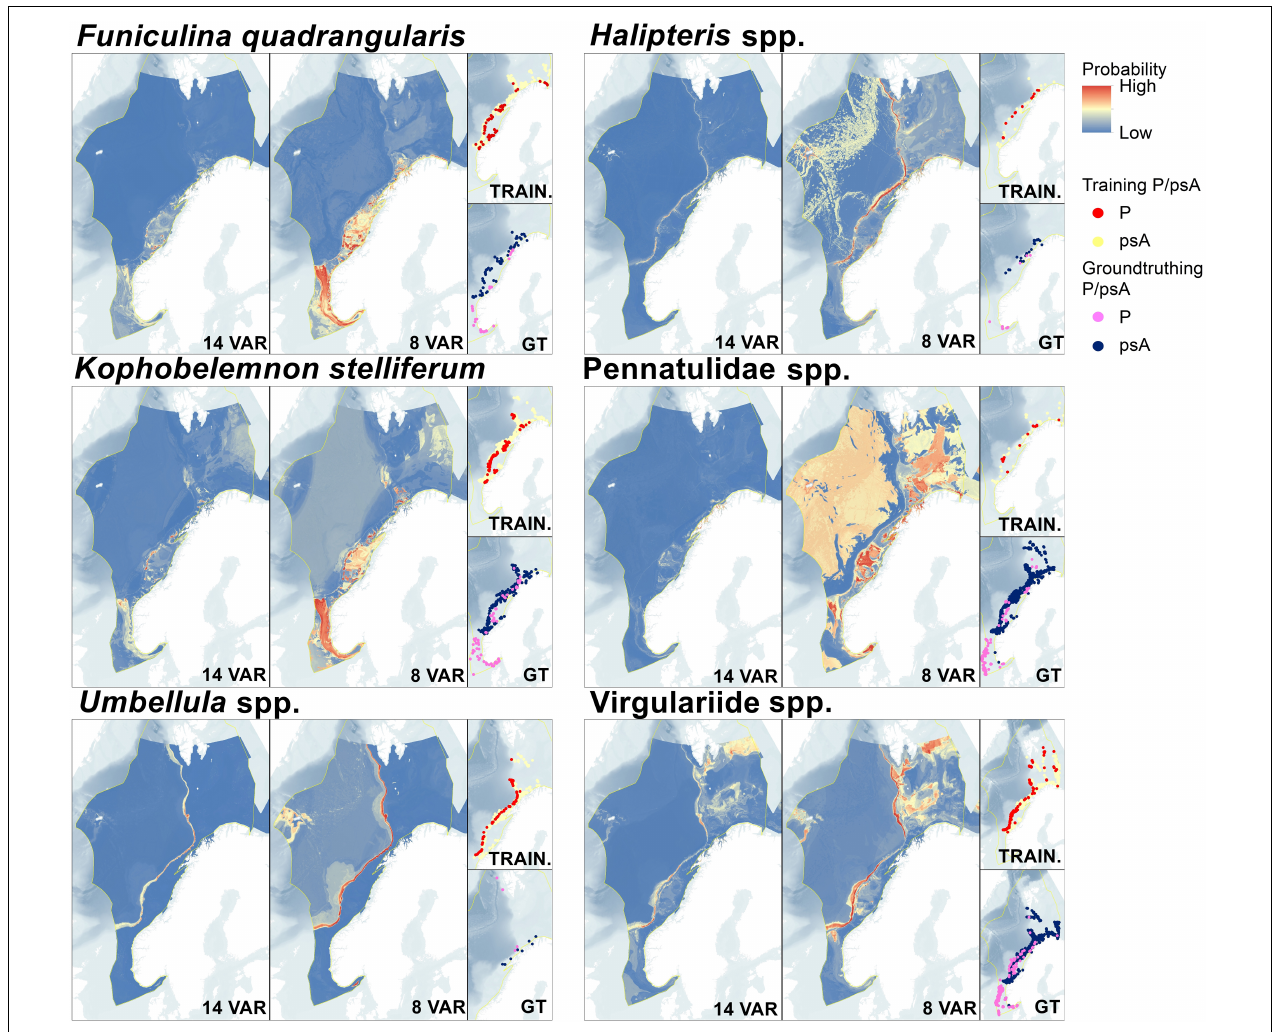
FIGURE 4 | Fourteen and eight variable prediction maps from ensemble SDMs for each taxon, together with inset maps displaying training and ground-truthing Presence/pseudoAbsence locations.